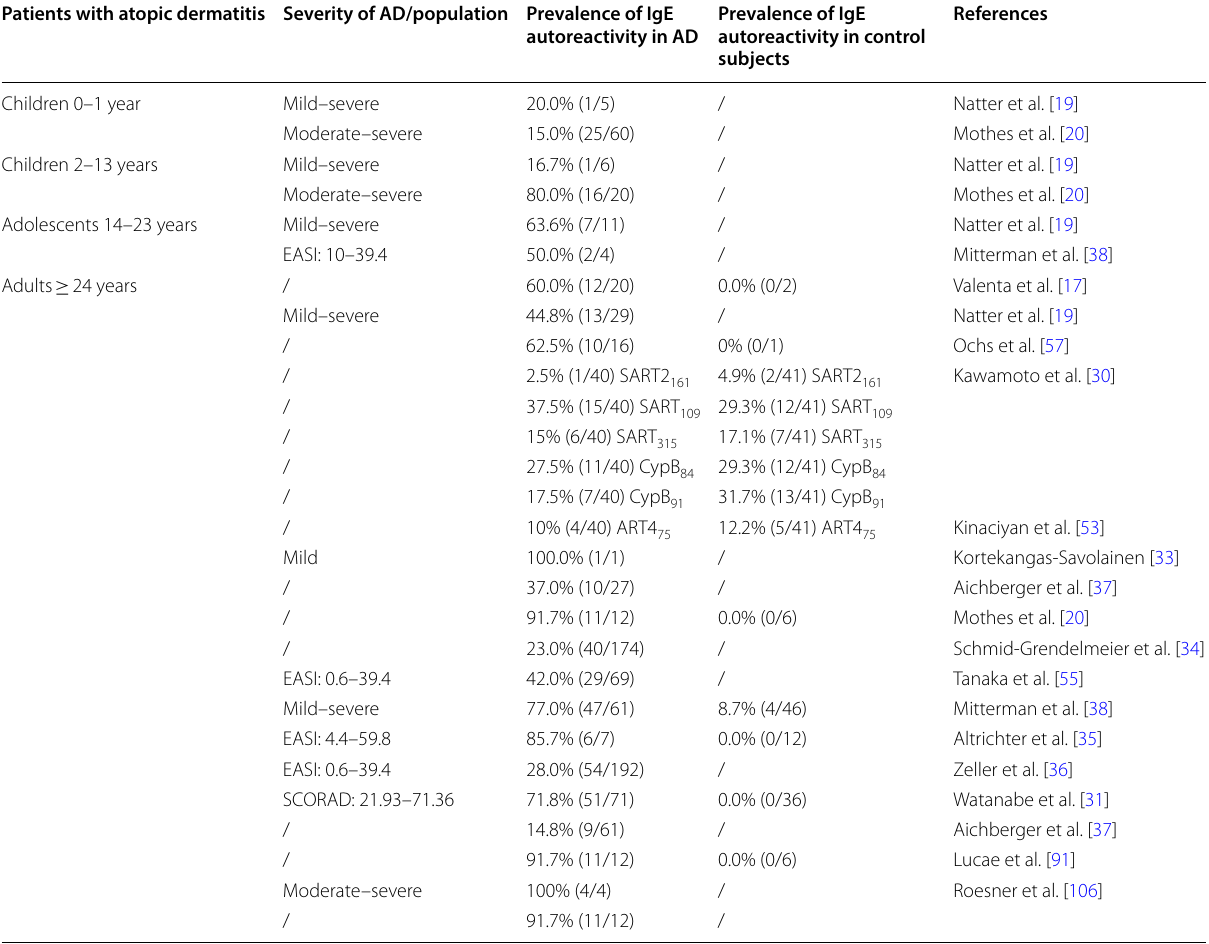
Percentage of IgE autoreactivity in atopic dermatitis with the severity of the disease compared with healthy subjects, subdivided into children 0–1 year, 2–13 years, adolescents and adults